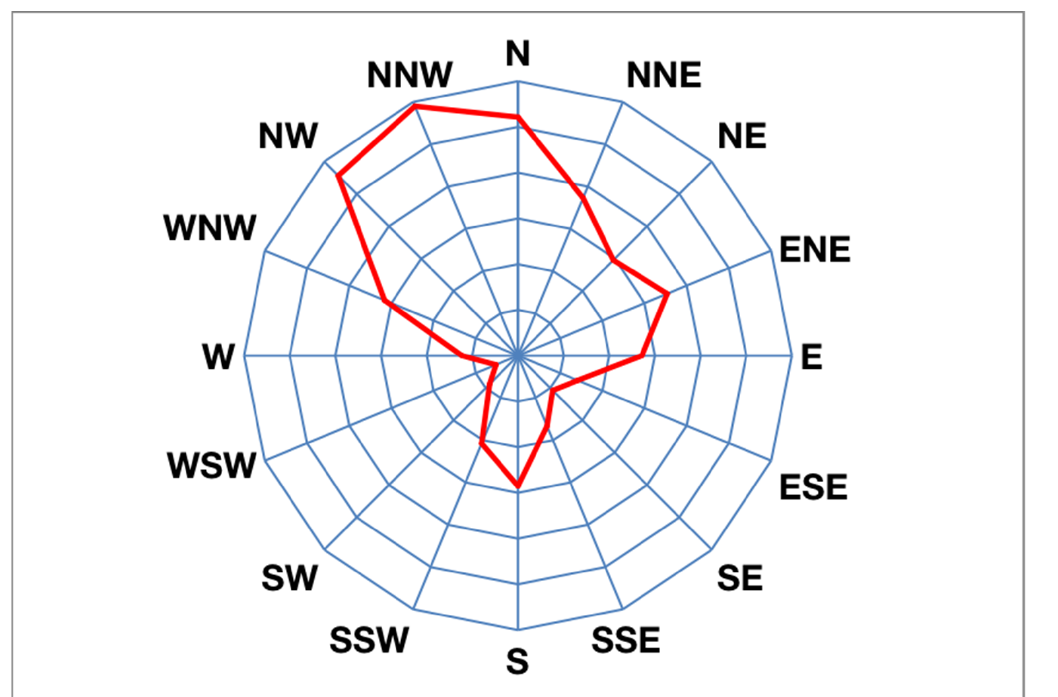
Figure 2. Winter wind rose illustration of Deqing City.